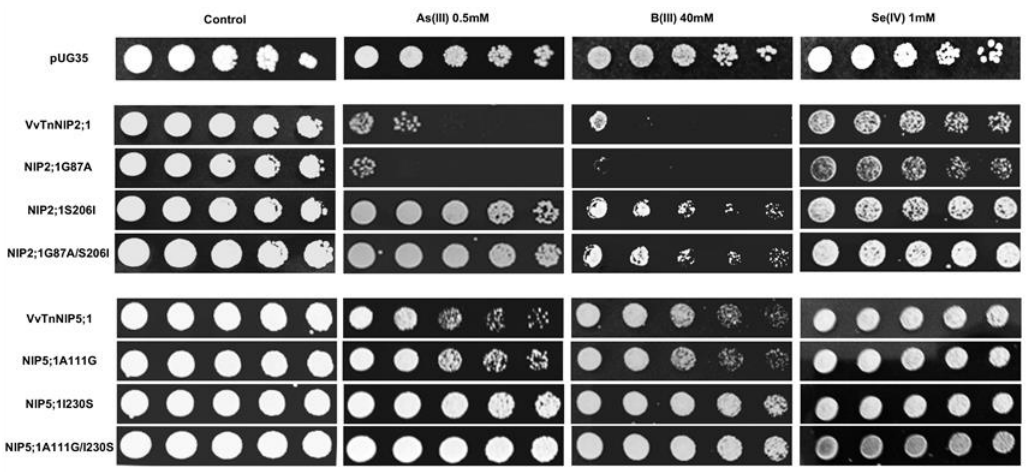
Figure 8. S. cerevisiae aqy-null strain expressing grapevine native NIPs (VvTnNIP2;1 and VvTnNIP5;1), and their ar / R filter mutants. Native strains exhibited sensitivity toward metalloids (As, B, and Se), which was altered by amino acid substitution at H2 / H5 residue. Yeast strain transformed with empty plasmid pUG35 plasmid was considered as control. Cells were spotted in 10-fold dilution on plates containing the indicated concentration of test substrates. Minimal media plate without any additional substrate is considered as control. Growth was recorded after one week at 28 ◦ C. Photographs are representative of at least two independent experiments having two replicate plates showing consistent results.